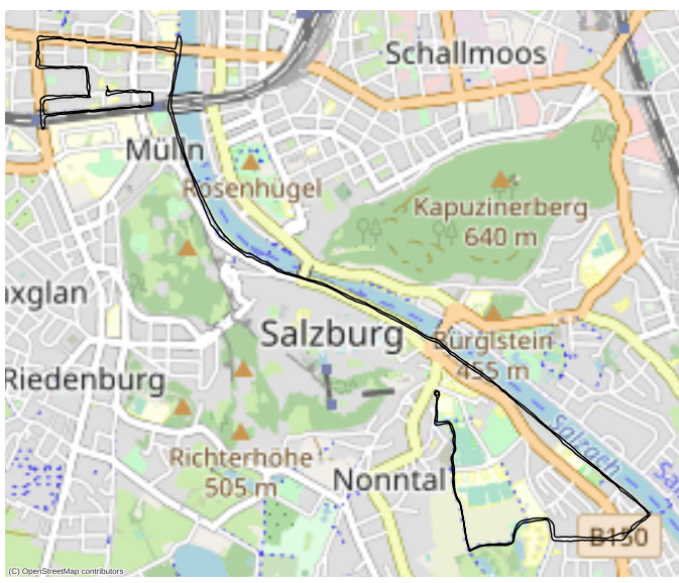
Figure 6. Location data from a test run plotted on a